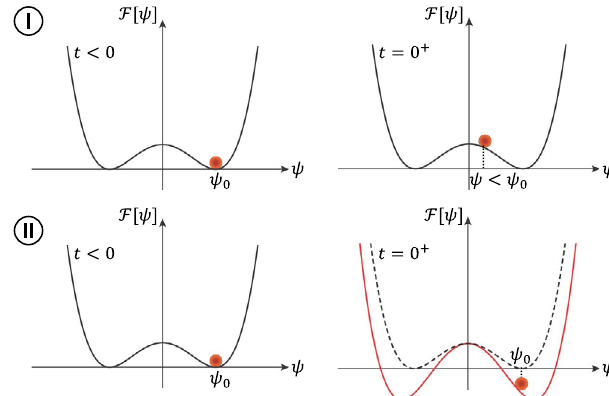
Fig. 2 Theoretical modeling of an impulsive optical quench. We consider two situations: the laser pulse partially suppresses the order parameter expectation value (I) or it affects the coef fi cients of the Ginzburg-Landau free energy